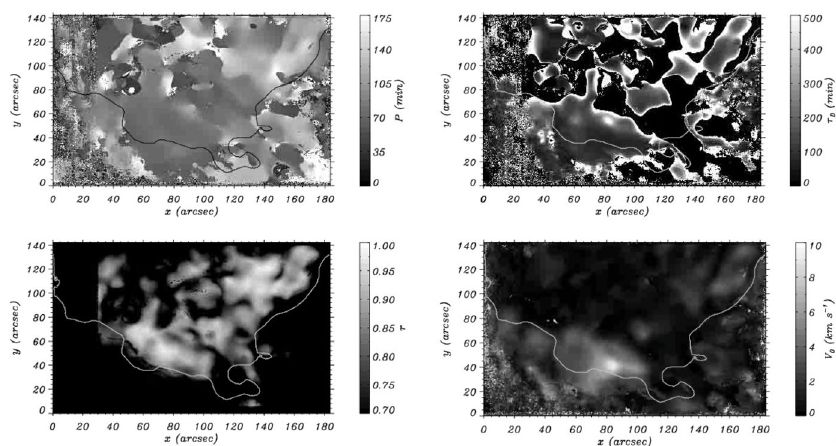
Fig. 17 Results of fitting the function of Fig. 16 to the Doppler velocity in the whole two-dimensional field ofview.Thespatialdistributionofthefittedperiodanddampingtimeisshowninthetoppanels,whilethatof the correlation coefficient and fitted amplitude is displayed in the bottom panels. The continuous white line (black in the top left panel) represents the approximate position of the prominence edge. The photosphere is slightly outside the image top. Image reproduced with permission from Terradas et al. (2002), copyright by